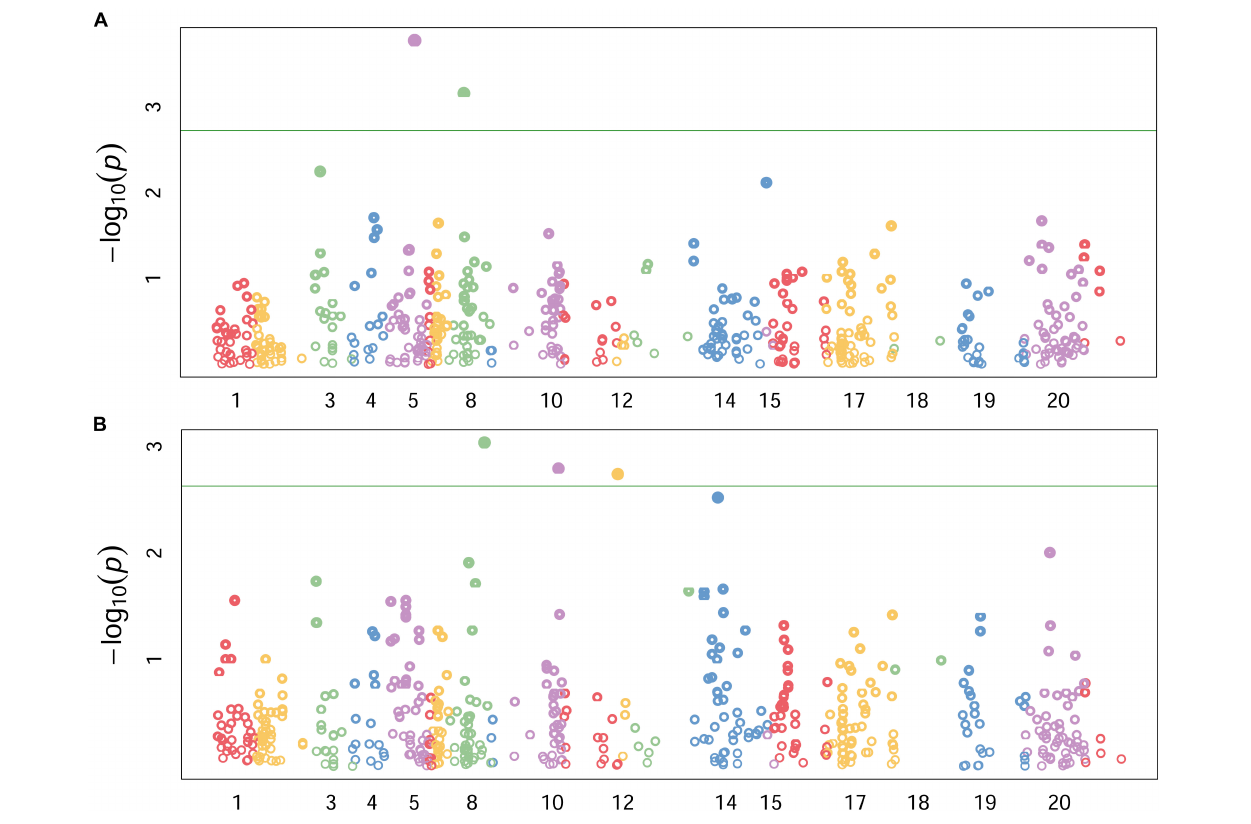
FIGURE 3 | Genomic locations of significant QTLs under stress (A) , and non-stress (B) conditions. Numbers along the horizontal indicate individual chromosomes. Labels for some chromosomes with smaller number of markers are omitted (can be seen from the diffenet colors) to avoid cluttering the graph. Data pionts above the horizontal green line showed adjusted p- values <